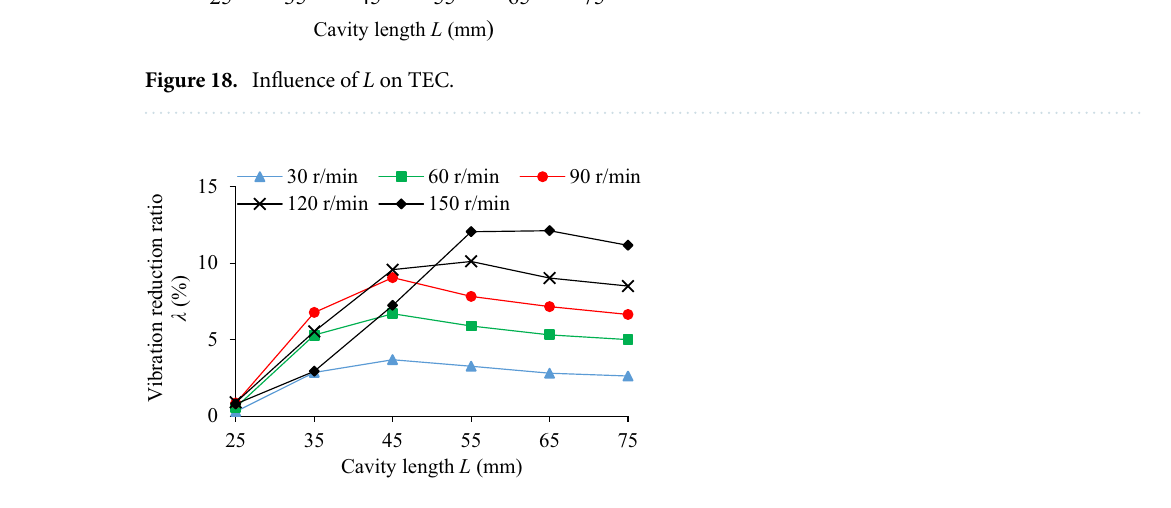
Figure 19. Influence of L on